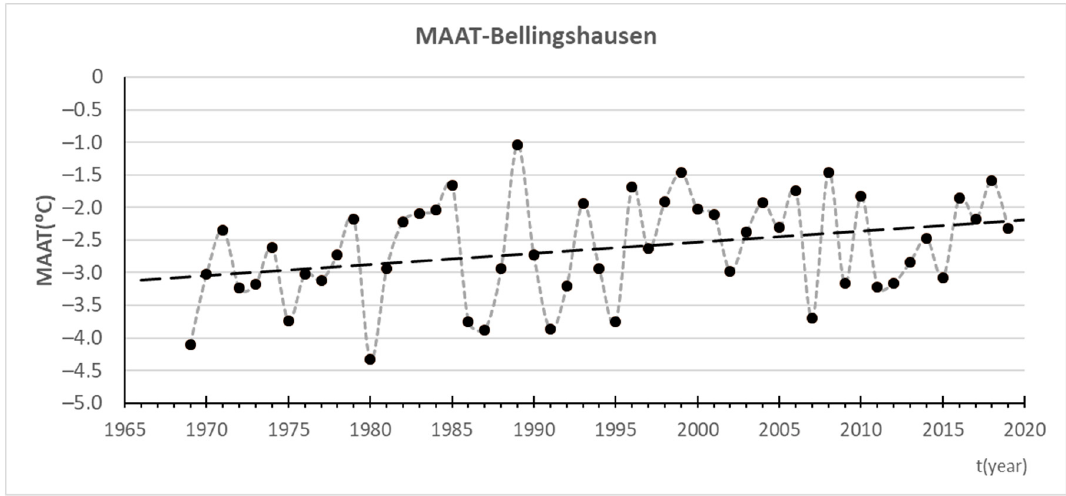
Figure 1. Mean annual air temperature in Bellingshausen station (King George Island) from 1968 to 2020. Data from SCAR Reference Antarctic Data for Environmental Research [12].